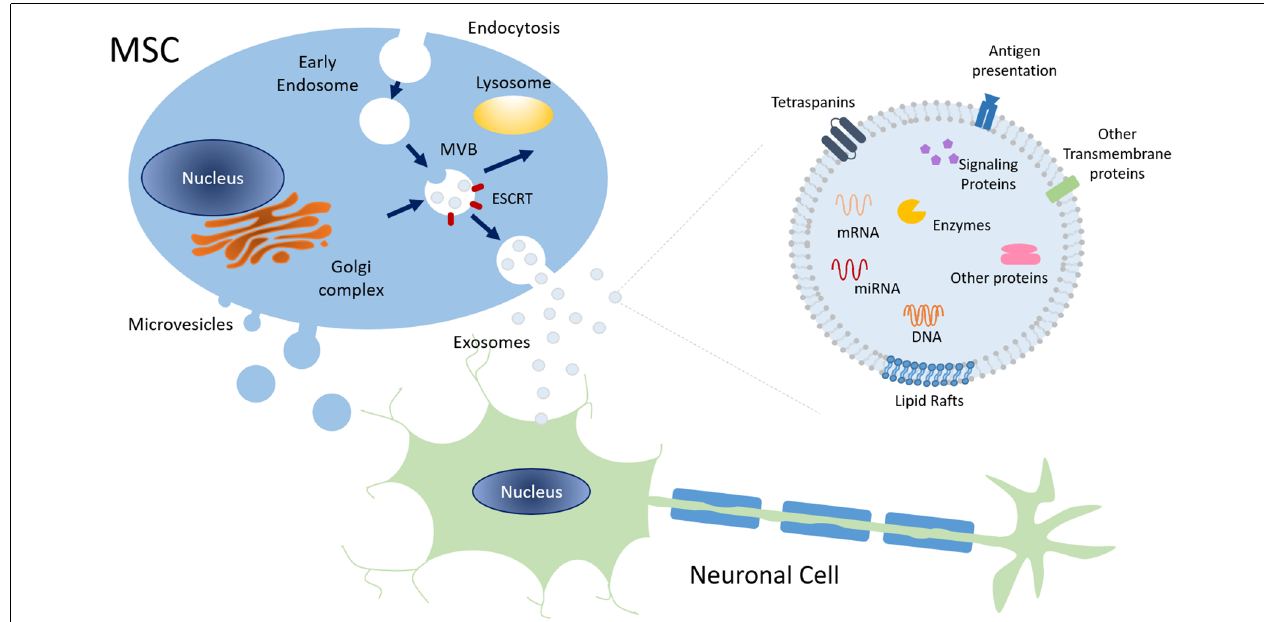
FIGURE 3 | Schematic representation of exosome biogenesis and molecular composition. Exosomes have an endocytic origin and are released to the extracellular milieu upon the fusion of MVB with the plasma membrane. Other MVB may fuse with lysosomes leading to their degradation. Overall, exosomes surface markers, cytoskeleton, and cellular metabolism proteins are common to those of the cell of origin. Plus, exosomes also include signaling proteins, DNA, several types of RNA, and lipids. Abbreviations: ESCRT, Endosomal Sorting Complex Required for Transport; MVB, Multivesicular bodies; mRNA, messenger RNA, miRNA,